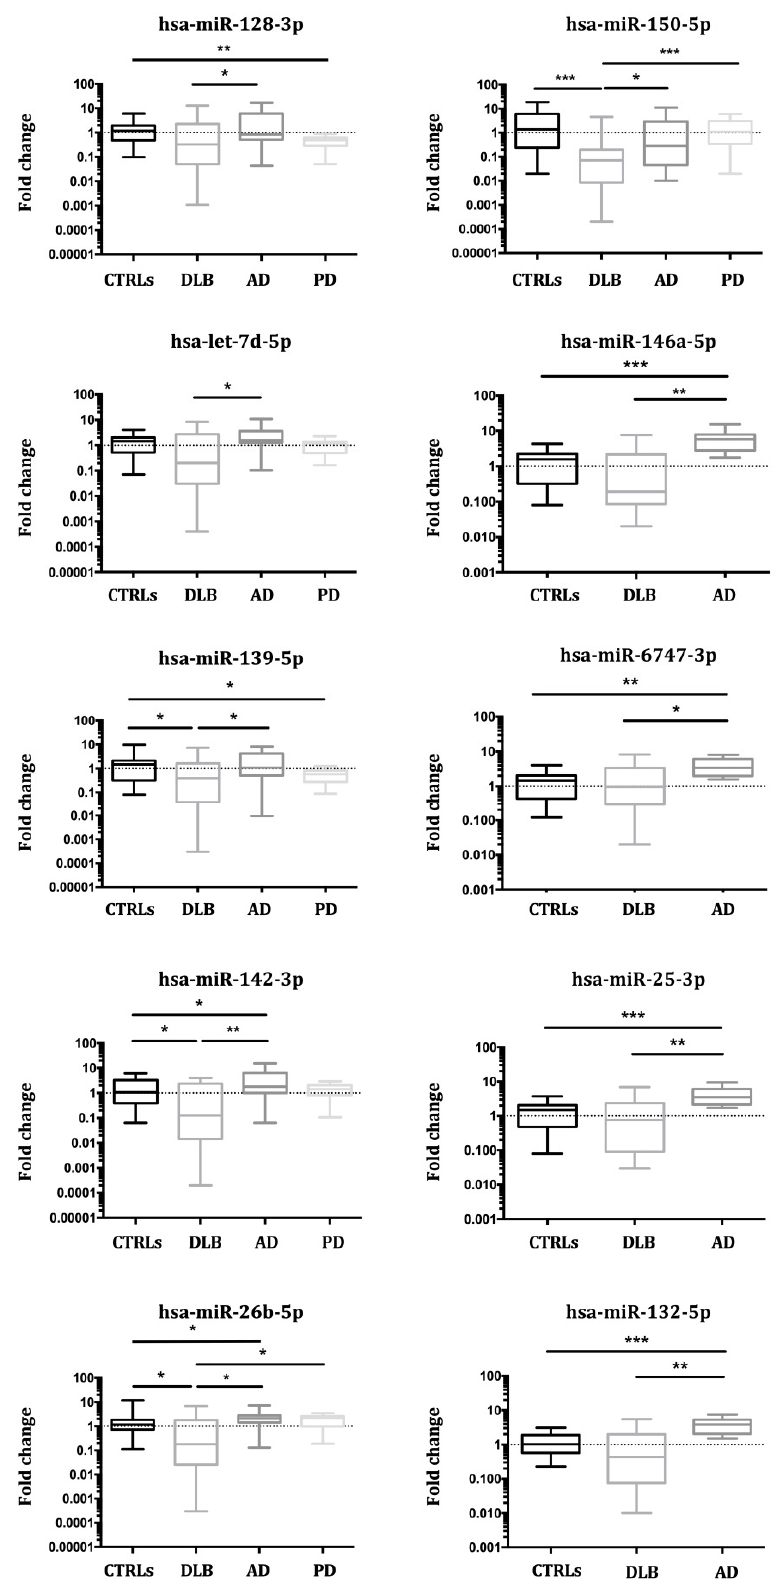
Figure 4. Combined results from three validation studies for miRNA expression in Controls, DLB, AD and PD. In all cases, mean and range for fold change are plotted; (* p < 0.05, ** p < 0.001, *** p < 0.0001).